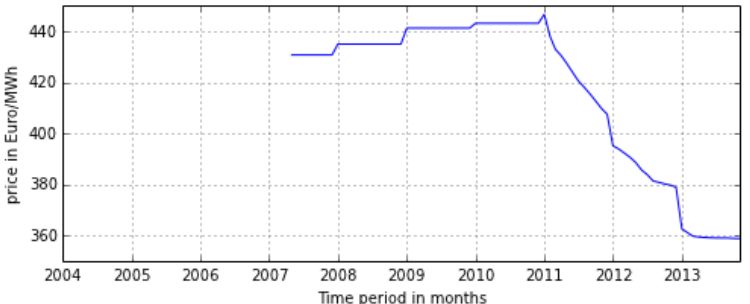
Figure 5. Generation ‐ weighted average PV power price for the period from January 2004 to November 2013.